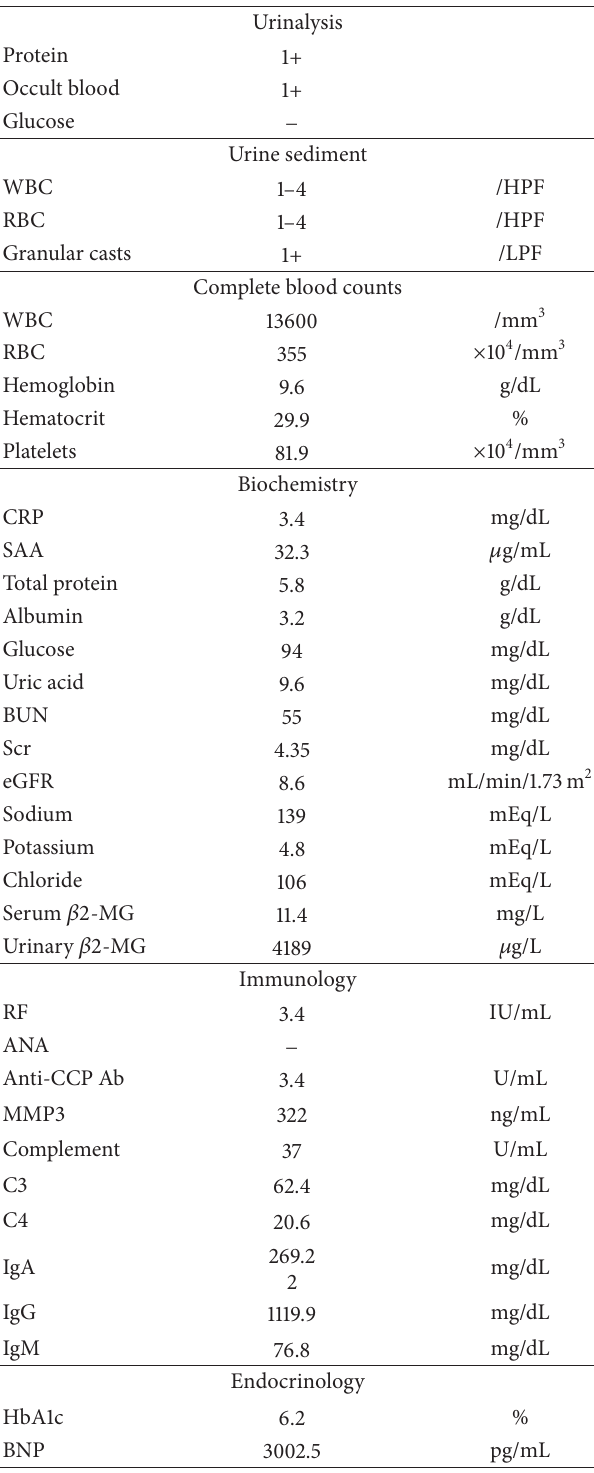
Table 1: Laboratory findings on